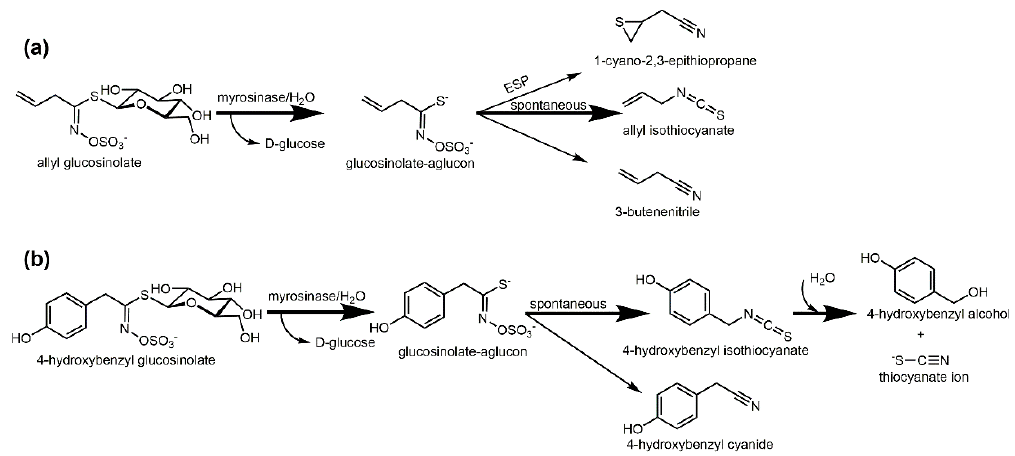
Figure 1. Enzymatic hydrolysis of glucosinolates during biofumigation. ( a ) Hydrolysis of allyl glucosinolate from Brassica juncea to the corresponding isothiocyanate, nitrile, or, if epithiospecifier proteins (ESP) are present, to the corresponding epithionitrile; ( b ) Hydrolysis of 4-hydroxybenzyl glucosinolate from Sinapis alba and hydrolysis of the released 4-hydroxybenzyl isothiocyanate to the corresponding alcohol and thiocyanate ions.